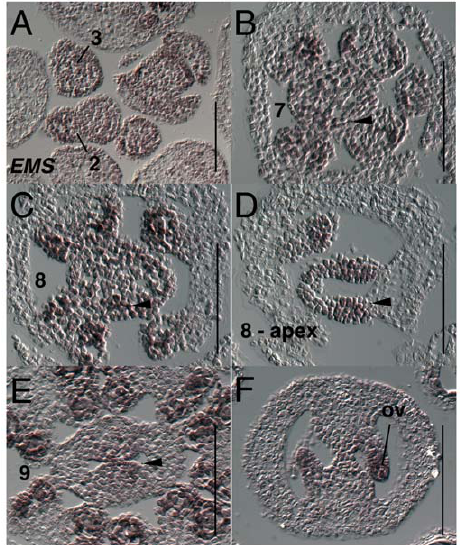
Figure 11. Results of insitu hybridization with LFY antisense probe. Numbers indicate floral stages. All panels show transverse (cross sectional) tissue orientation. Arrowheads indicate medial domain expression. ov - ovule; Scale bars in all panels are 100 microns. All panels are Col-0 wild type tissue except as marked.